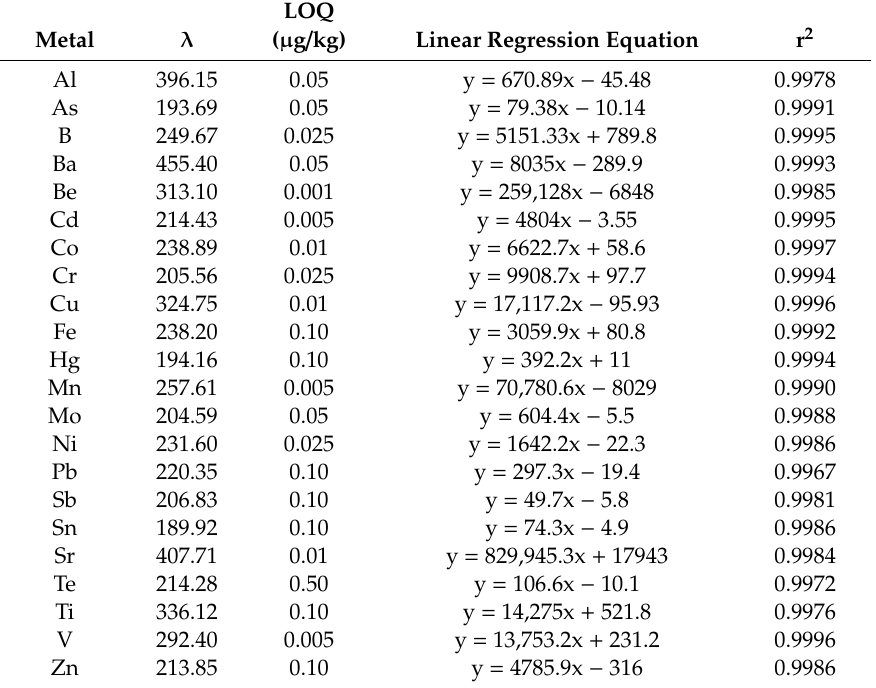
Table 2. Metal method parameters, limit of quantification (LOQ), correlation coefficient, and quantification wavelength ( λ